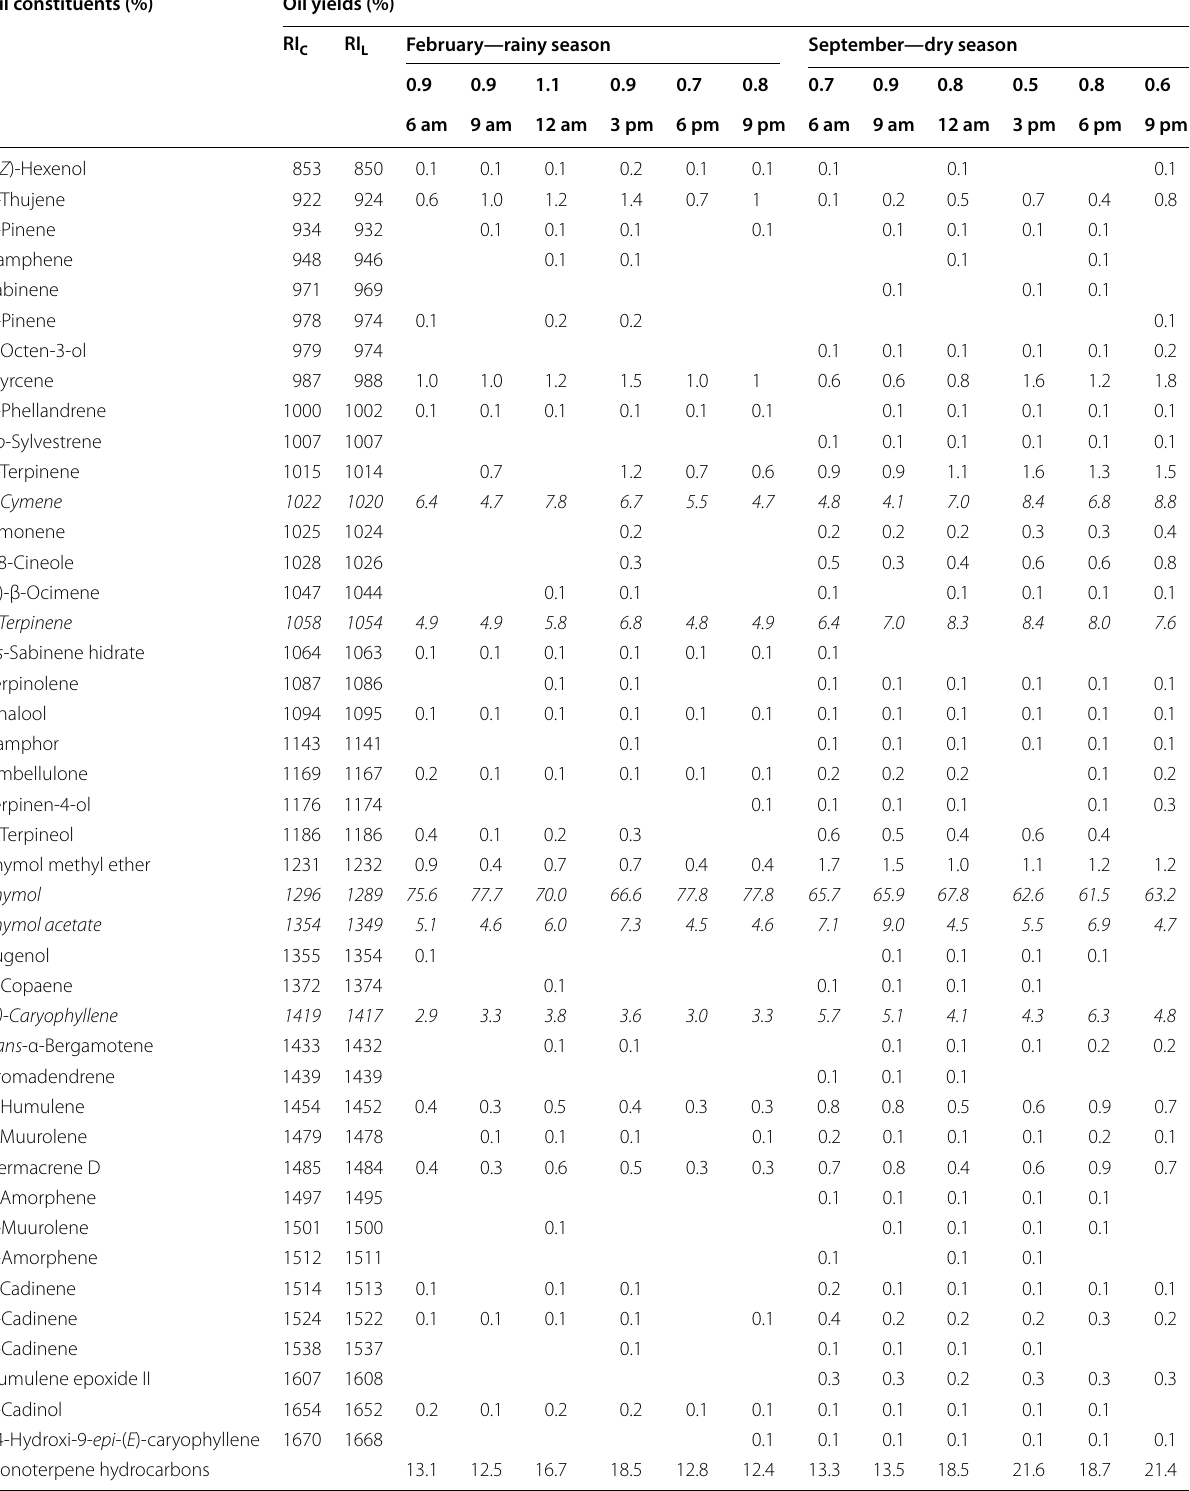
Table 3 Circadian study of the Lippia thymoides oils on the rainy and dry seasons Oil constituents (%) Oil yields (%) RI